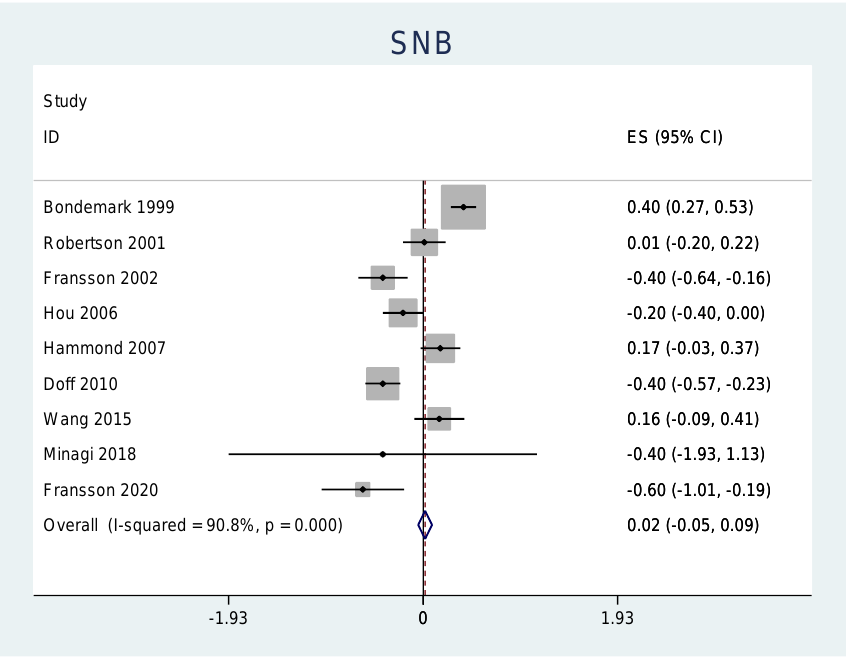
Figure 3. Forest plot of the results of SNB changes using the random-effects model.